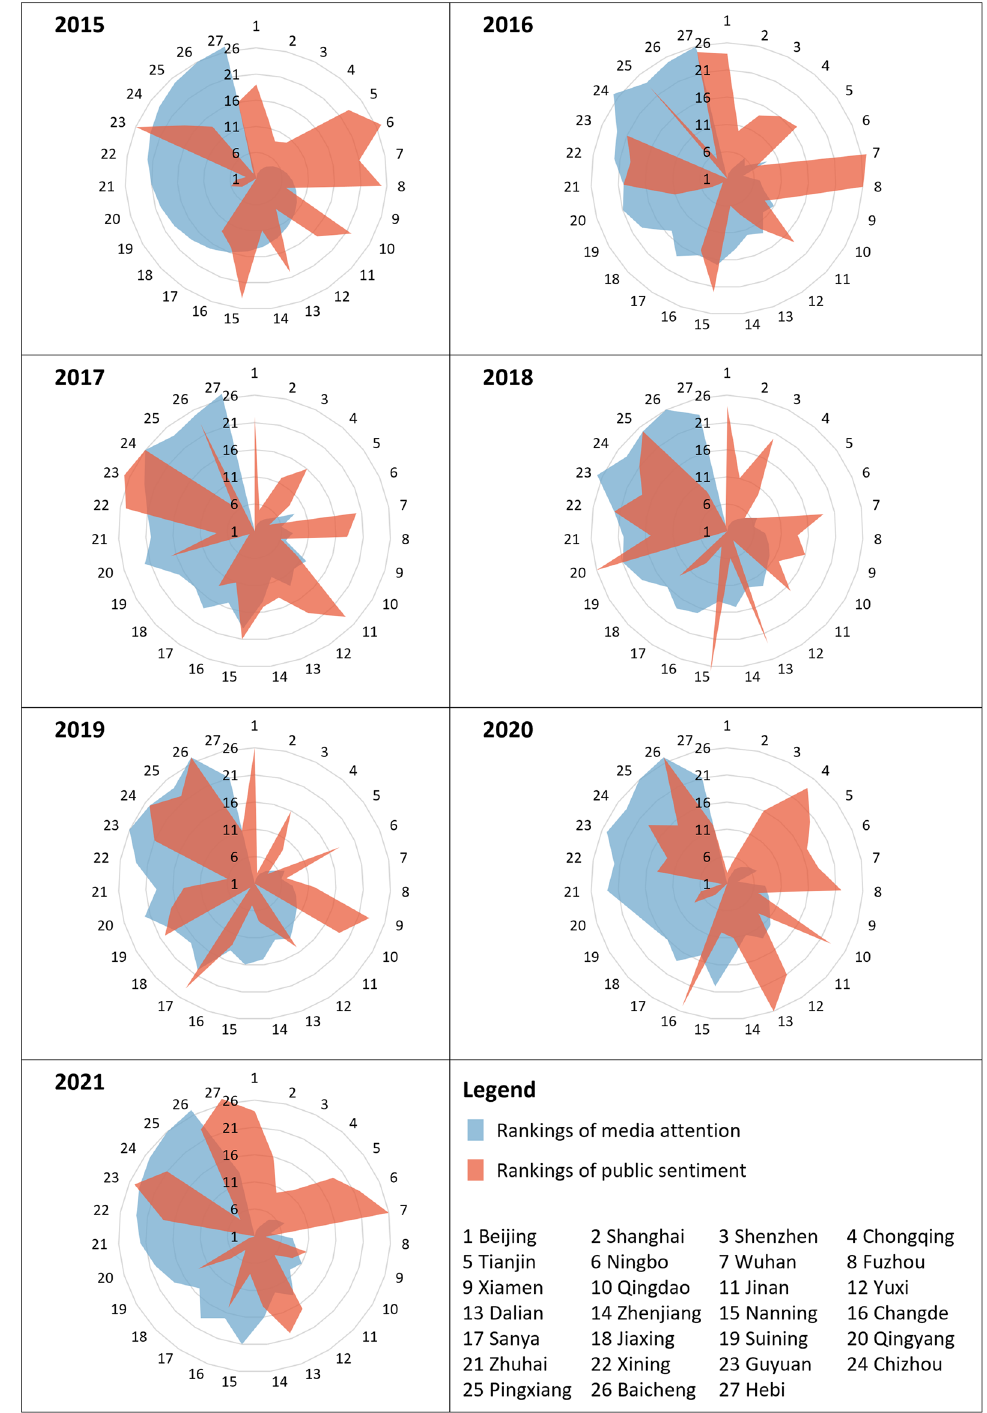
Figure 3. Annual variations of news media responses towards urban floods in different cities from 2015 to